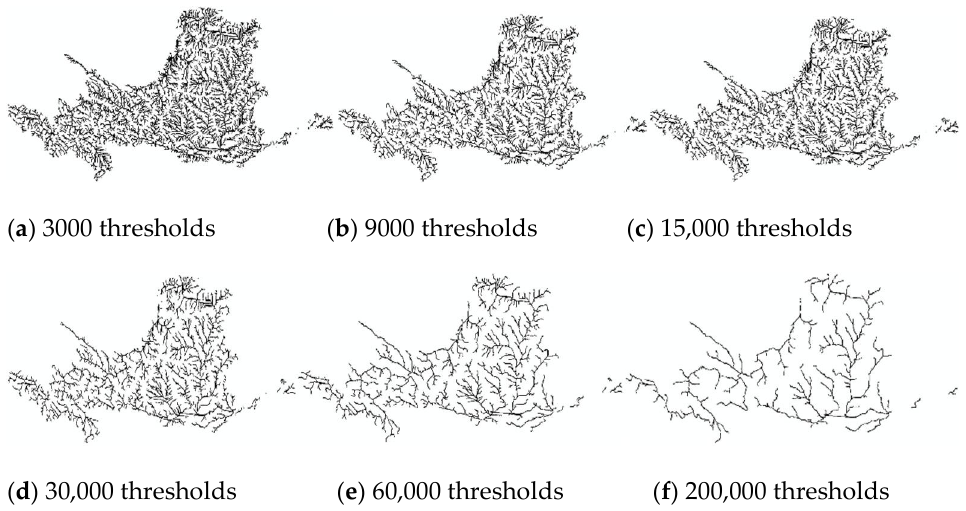
Figure 3. Map of river network under different thresholds of YRB. At thresholds between 3000 and 15,000 ( a – c ), the decrease in river network length is not visually significant. At thresholds above 30,000 ( d – f ), the river network changes significantly.